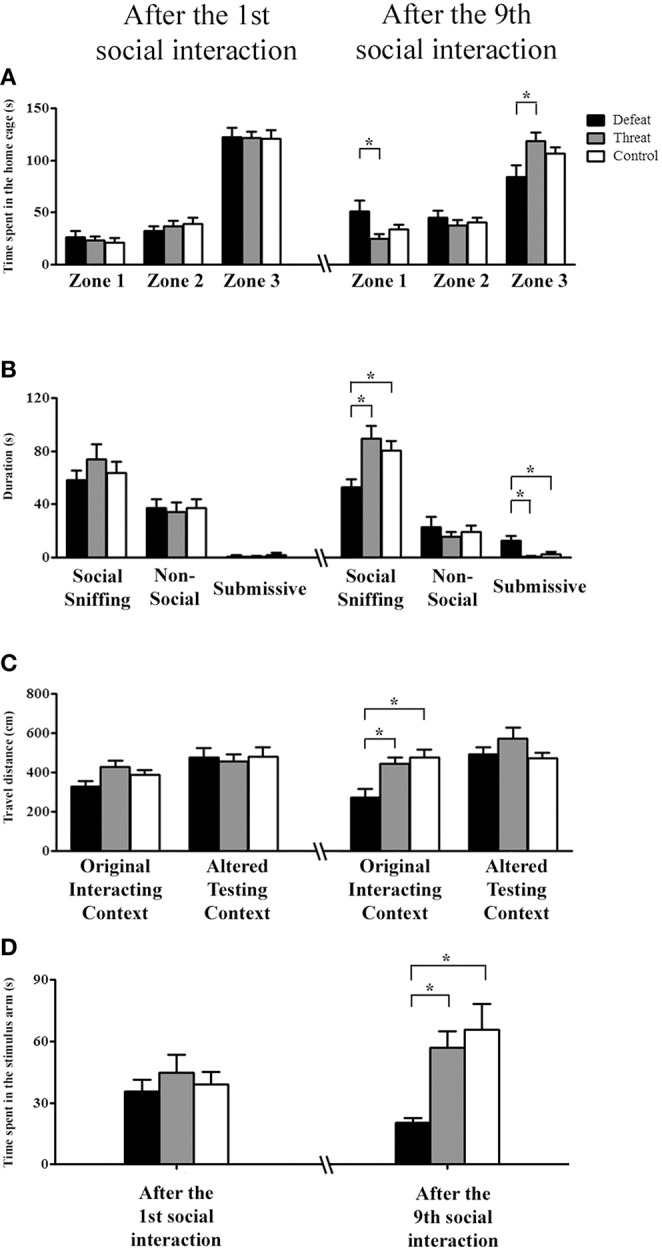
The behavioral performances (means ± SEM) in the three different testing contexts of Experiment 1 were evaluated after experiencing the 1st (postnatal day 33, left panels) and the 9th (postnatal day 66, right panels) social interactions in the social defeat group (black bars), the “social threat” group (gray bars) and the arena control group (white bars, batch #1, n = 12 per group). (A,B) In Experiment 1a, the total time spent in each of the three zones and the total duration (s) of the three categorized behaviors in a familiar, social context (i.e., the subject's home cage) were recorded. Distal zone: the zone farthest from the stimulus male; intermediate zone: the zone in the middle of the home cage; and proximal zone: the zone containing the metal basket with a restrained social stimulus male. Behaviors were categorized as non-social behaviors, social sniffing behaviors, or submissive behaviors. (C) In Experiment 1b, spontaneous locomotor activity (cm) in a familiar, non-social context (i.e., the original interaction context) and in an unfamiliar, non-social context (i.e., the altered experimental context) was recorded. (D) In Experiment 1c, the total social investigation time (s) in the stimulus arm of the U-shaped maze (i.e., an unfamiliar social context) was recorded. *p < 0.05.